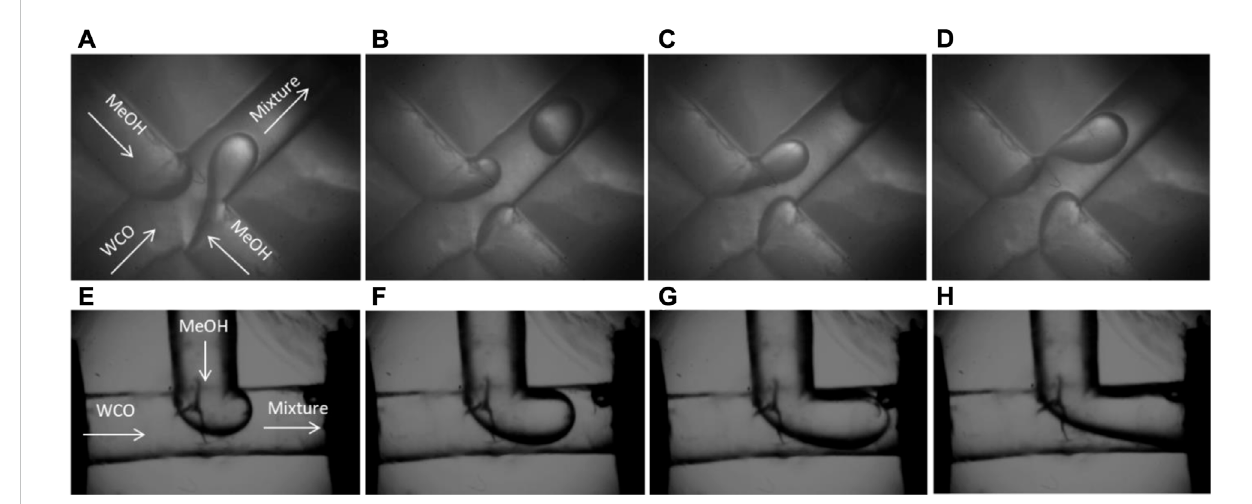
FIGURE 11 Evolution of plug fl ow in the cross- fl ow mixer (A – D) and in the T-junction (E – H)